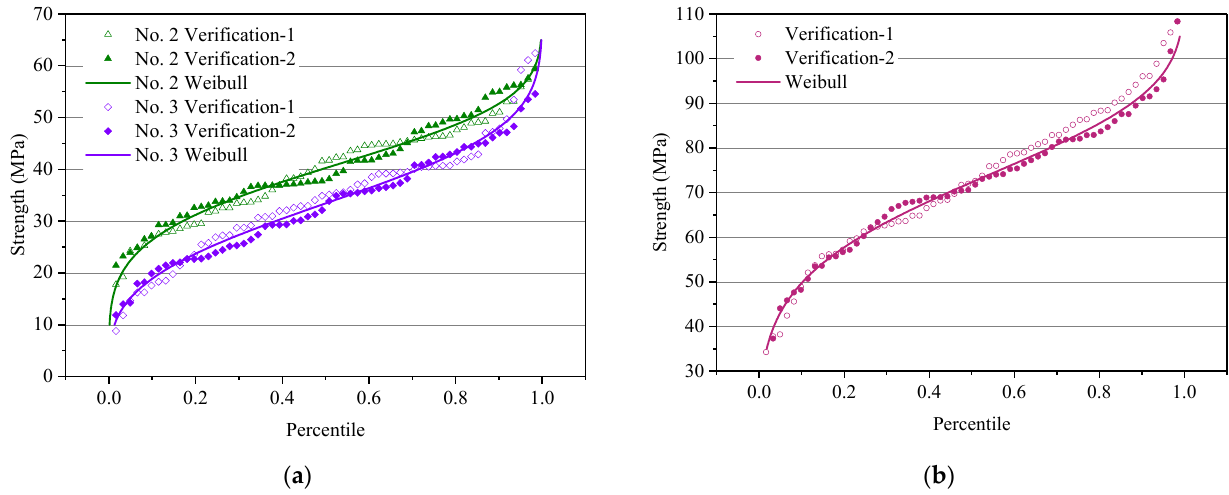
Figure 4. Verification of the calibrated 2-P Weibull distribution model. ( a ) Dimension lumber, ( b ) Small clear specimen. Table 3. Coefficient of determination R 2 of the verification.